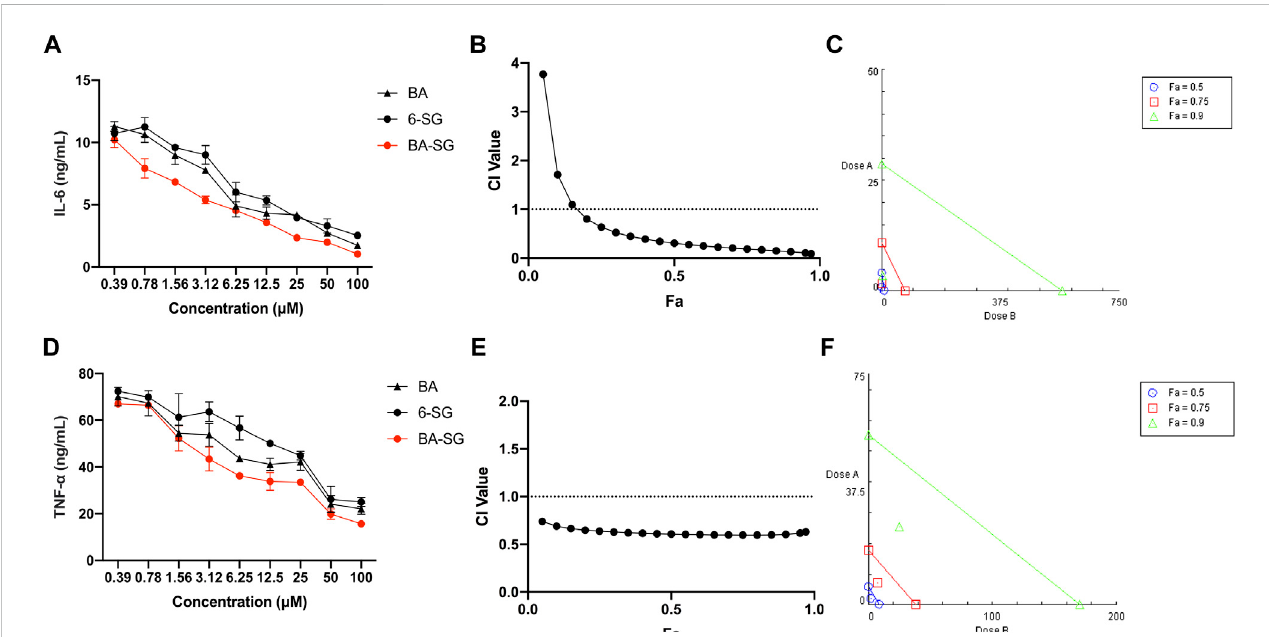
FIGURE 3 The BA-SG combination exhibited synergistic inhibitory effects on LPS-induced IL-6 and TNF- α productions in mono-cultured N11 cells. BA, 6-SG, and BA-SG dose-dependently inhibited LPS-induced IL-6 (A) and TNF- α (D) in N11 cells ( n = 3). The synergistic IL-6 (B) and TNF- α (E) inhibitory effects of BA-SG weredeterminedbytheCI-Facurves.CIvaluesrepresenttheinteraction inBA-SG,withCI < 1,CI =1andCI > 1referringtosynergy,additionandantagonism, respectively. Fa on the X -axis is de fi ned as the fraction effect level, and herein it refers to the IL-6 and TNF- α inhibitory effect, respectively. Isobologram analysis of BA-SG in IL-6 (C) and TNF- α (F) inhibition when the default set of Fa values at 0.50, 0.75, and 0.90. Data are shown as mean ±